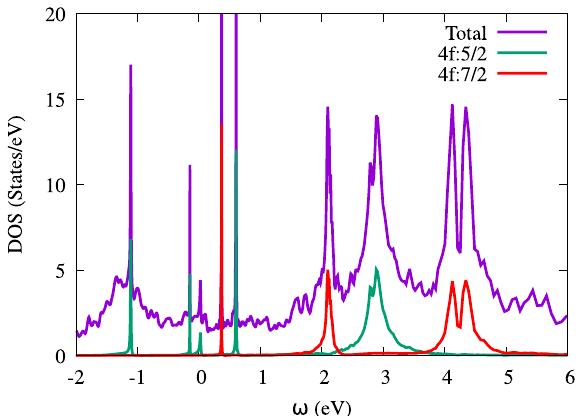
Figure 18. Total and partial DOSs of CeIn 3 calculated by LDA+DMFT at P =